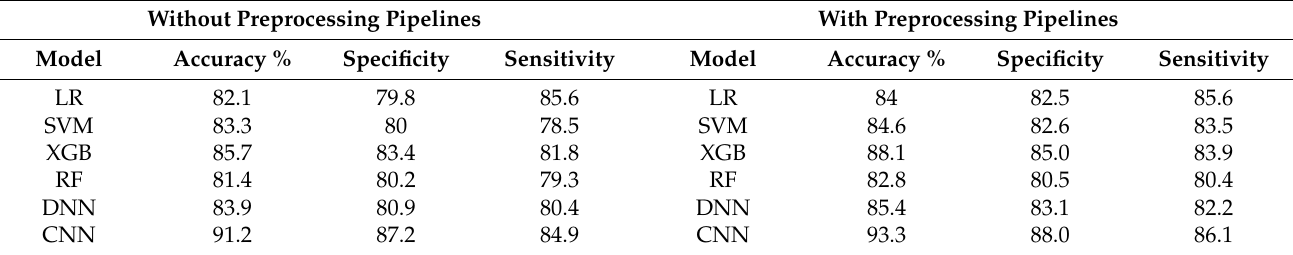
Table 3. Results for separate models (UCI dataset).